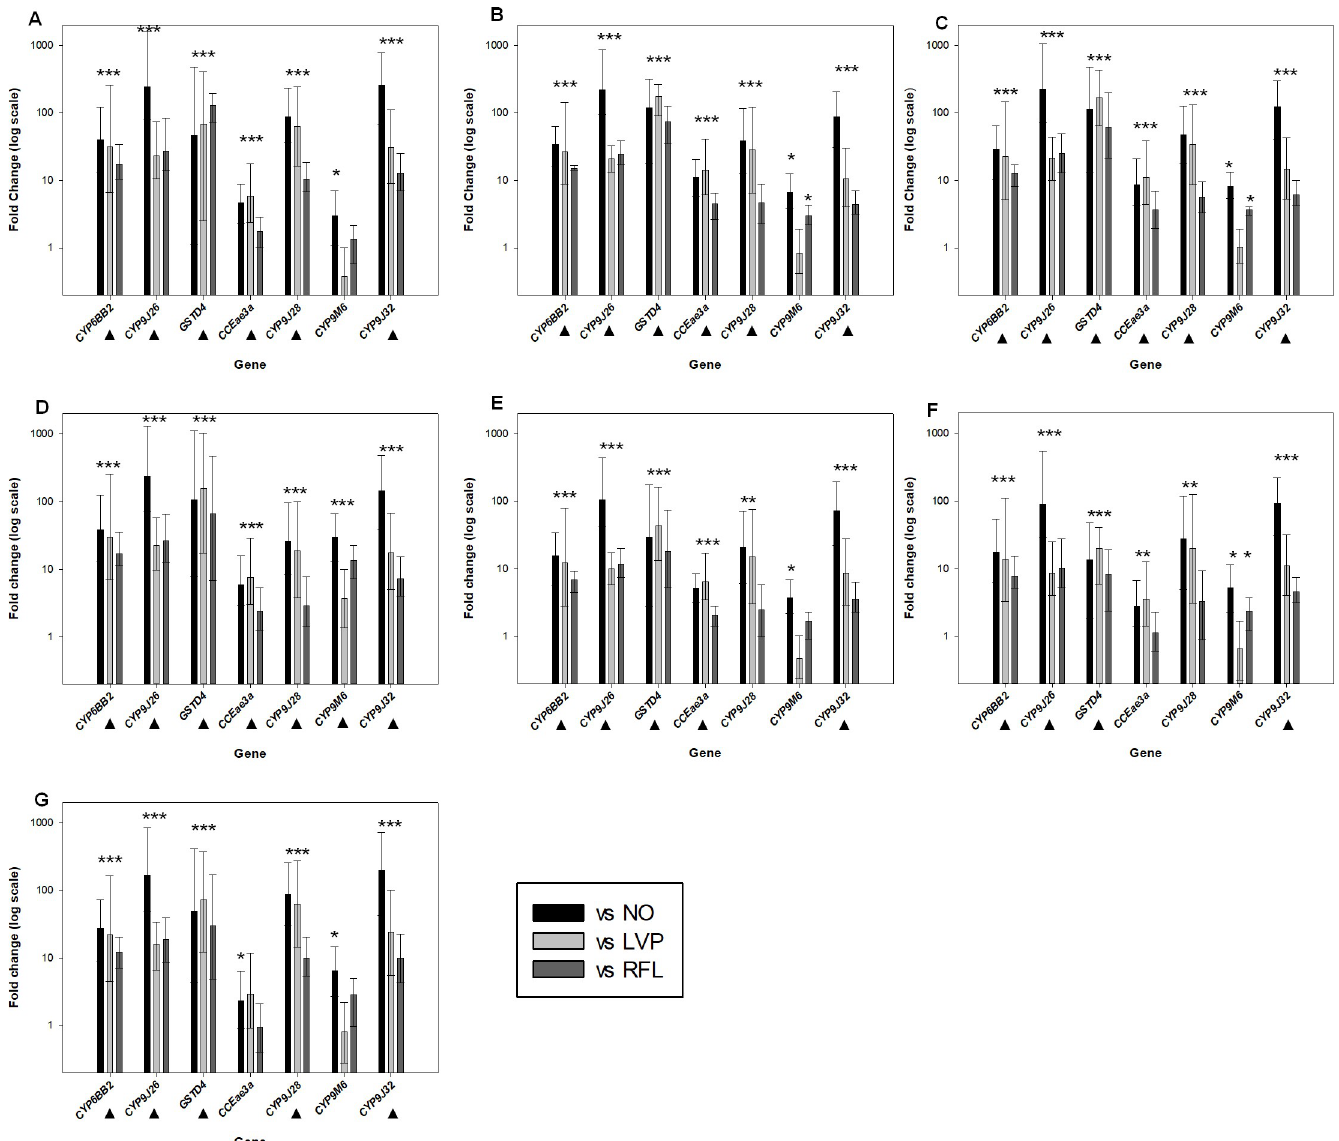
Fig 3. Expression analysis of detoxification genes in the seven resistant mosquito populations (respectively Mbour, Fatick, Louga, Touba, Dakar, Matam, and Barke´dji). Error bars indicate 95% CIs. Stars denote statistically significant upregulation.